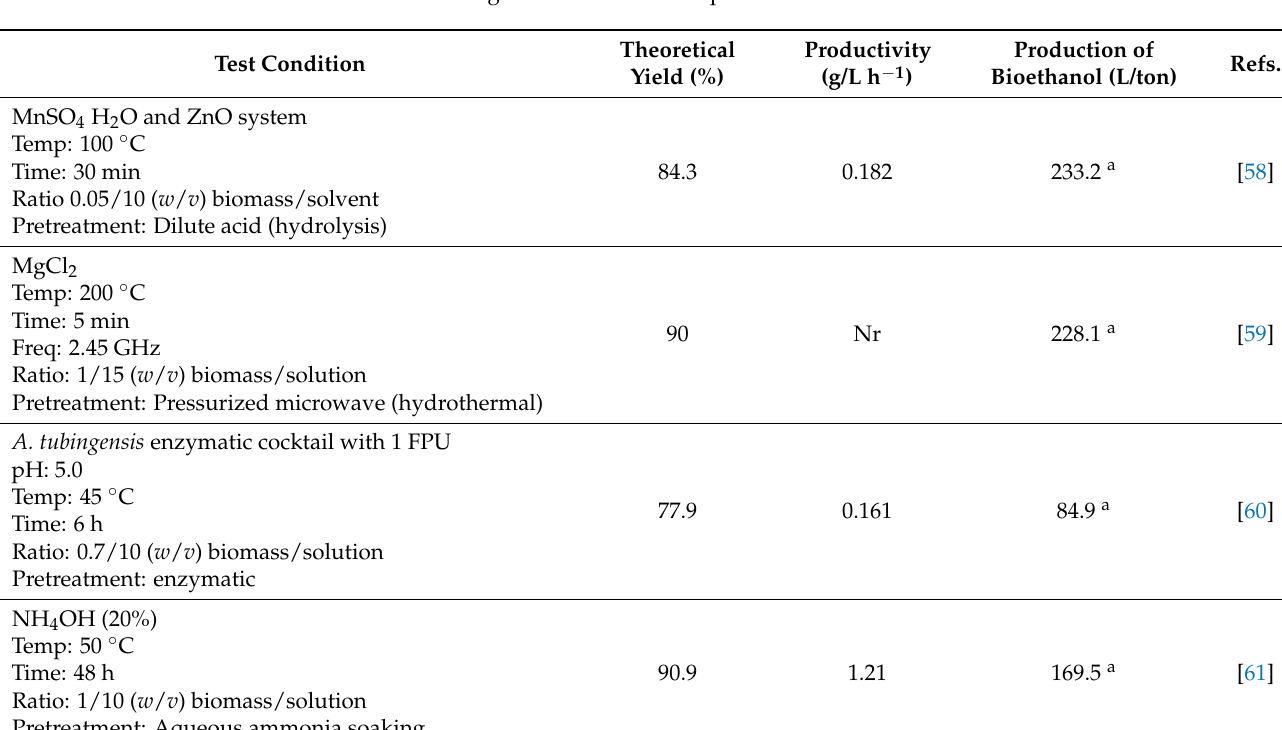
Figure 5. Bioethanol production from lignocellulosic biomass [46]. Table 2. Second-generation bioethanol production from